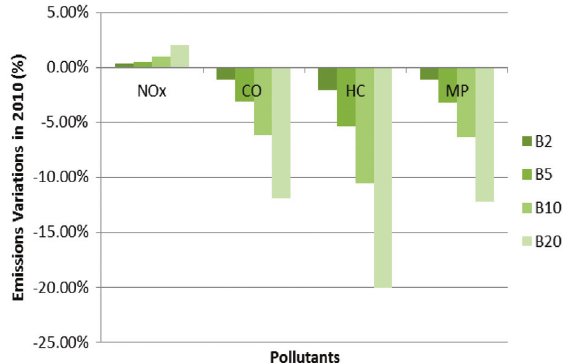
Fig. 5 - Variation of atmospheric emissions at different biodiesel blends added to diesel oil in 2010 in the MAPA.